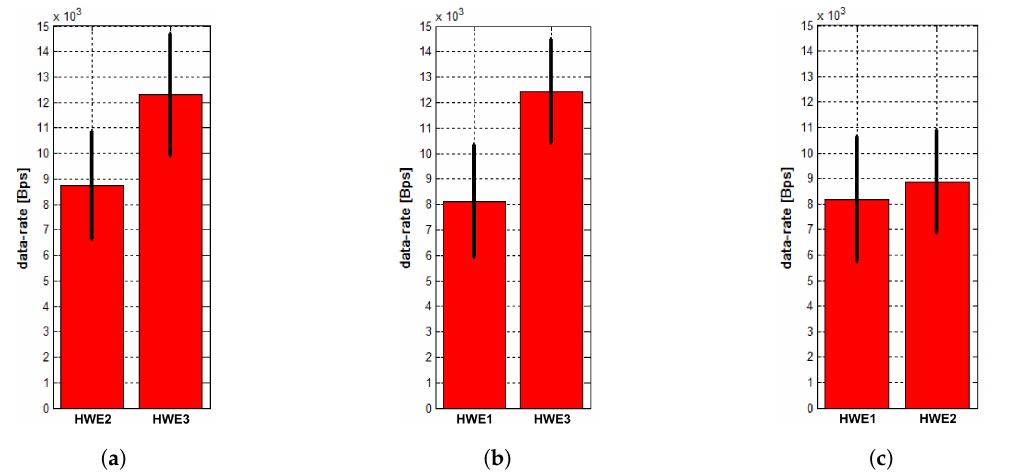
Figure 9. Mean values and standard deviation of data rates of transmissions from neighbors measured at entities ( a ) HWE 1 ; ( b ) HWE 2 ; and ( c ) HWE 3 in the HW scenario.